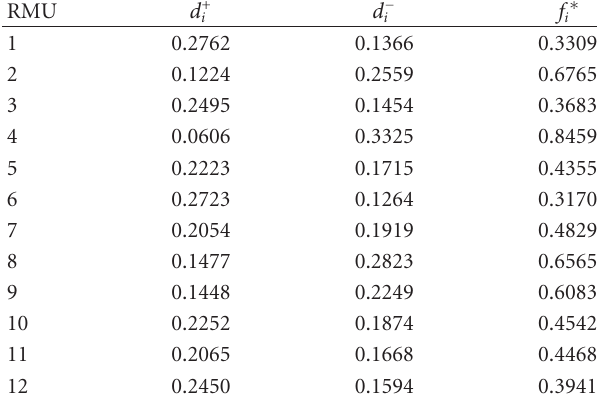
Table 6: The relative closeness of